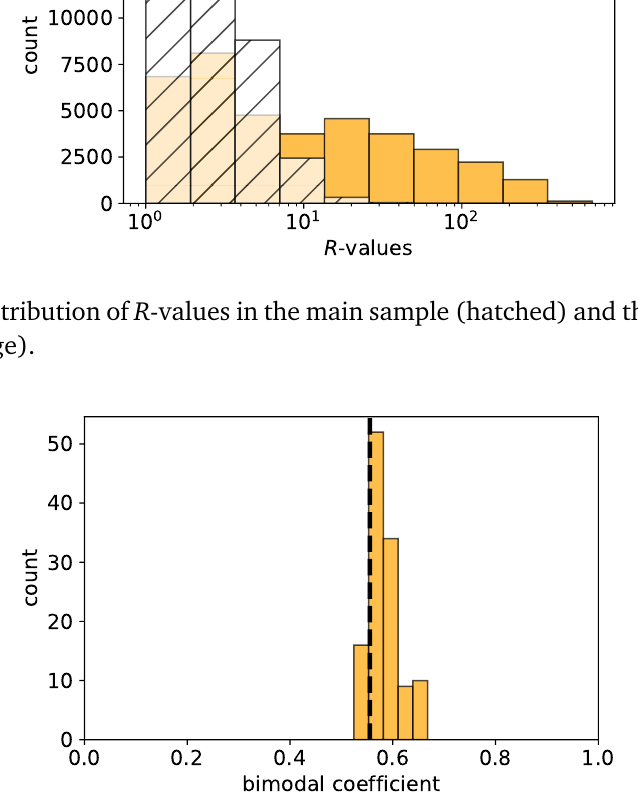
Figure 11: Distribution of the bimodal coefficient for hypercubes with the largest R -values (20 and above) in the main sample. No significant deviations from the flat- distribution value b = 5 / 9 (shown by a dashed line) are observed, indicating absence of